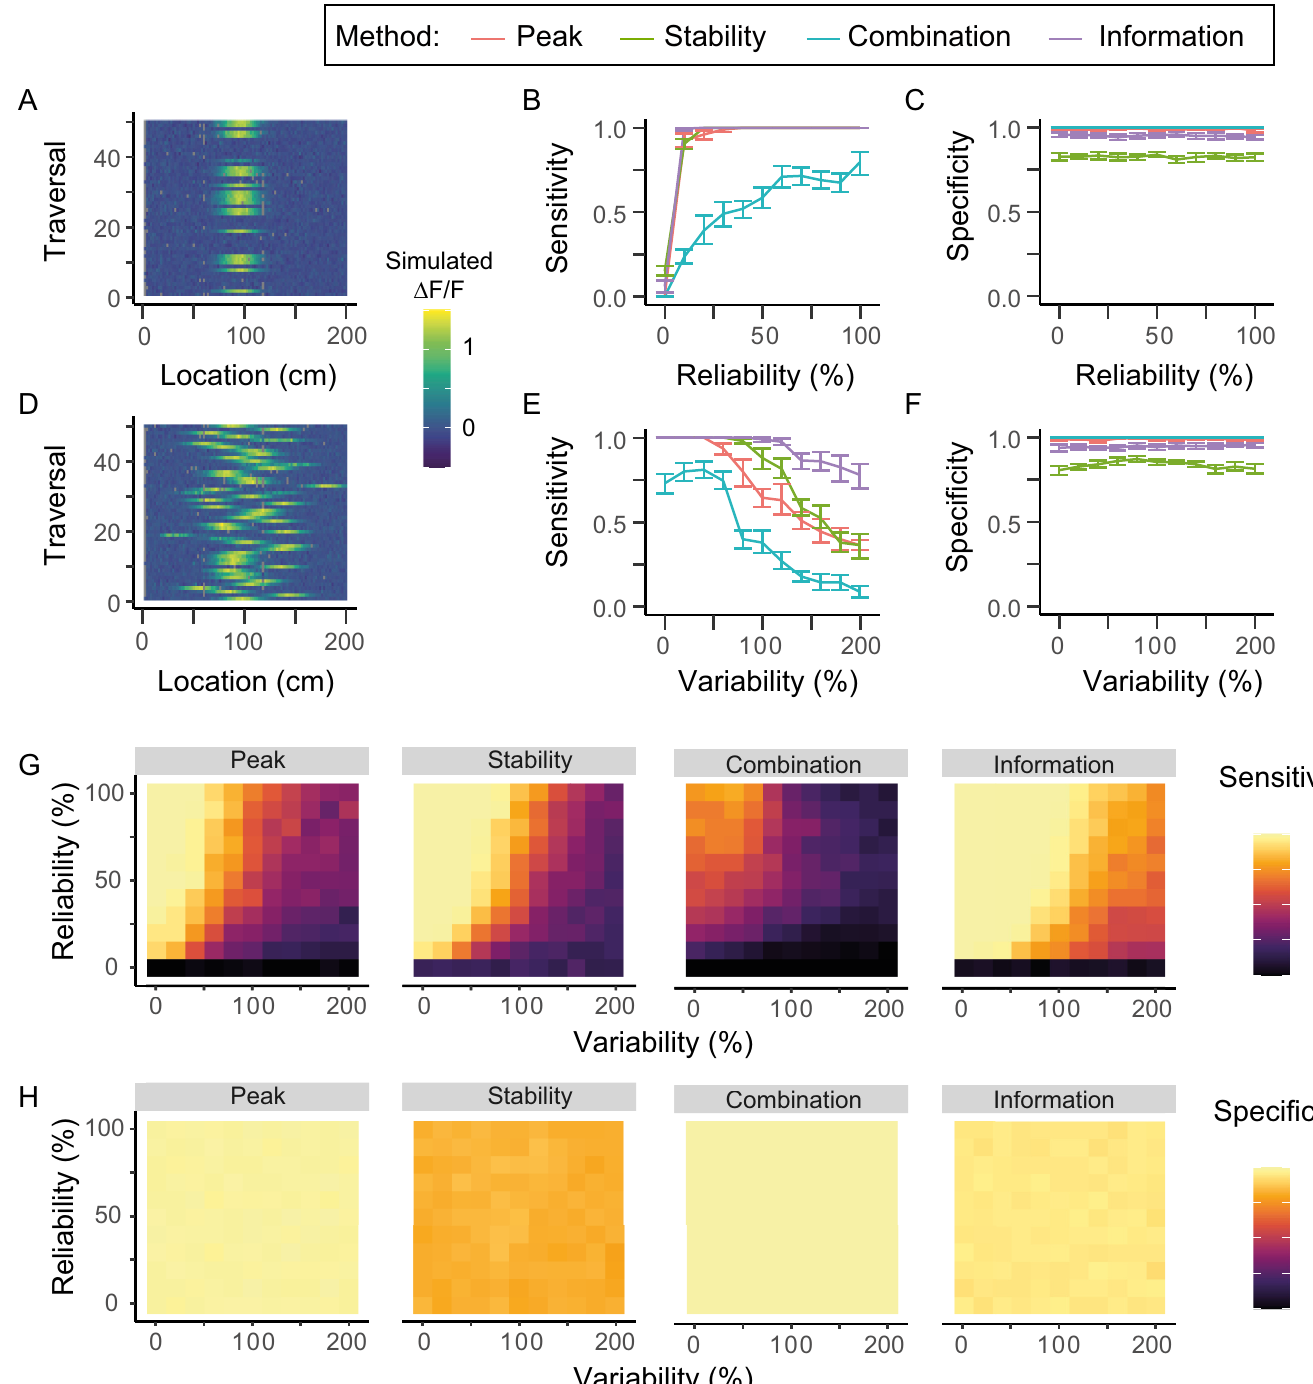
Fig 3. Place cell identification in variable and unreliable place cells. (A) Fluorescence map for a place cell with a reliability of 40% (B) Sensitivity of methods as a function of the reliability of a place cell. (C) Specificity of methods as a function of reliability. (D) Fluorescence map for a place cell with 60% variability. (E) Sensitivity of methods as a function of the variability of a cell’s place field across different traversals. (F) Specificity of methods as a function of variability. (G) Surface plots of the sensitivity of each method as a function of both reliability and variability. (H) Surface plots of the specificity of each method as a function of both reliability and variability. Grey points in A and D indicate the mouse did was not recorded at that location in that particular traversal, due to the limited frame rate of our recordings. Data shown are the means of 10 randomly created datasets, with the error bars representing 95% confidence intervals.